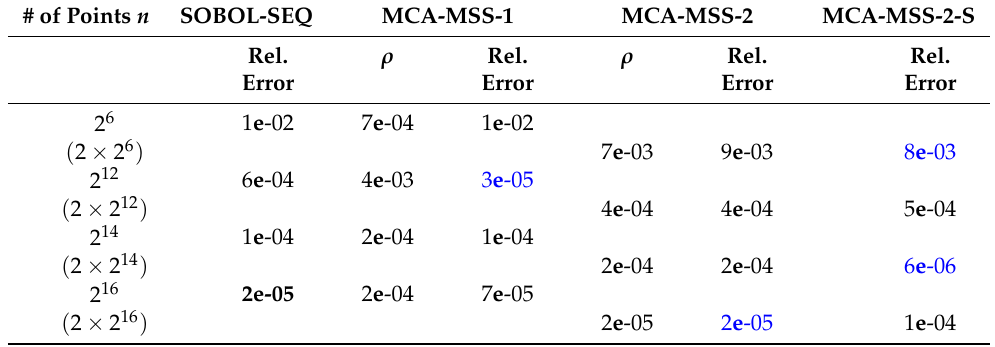
Table 8. RE for AE of D ≈ 0.0025.